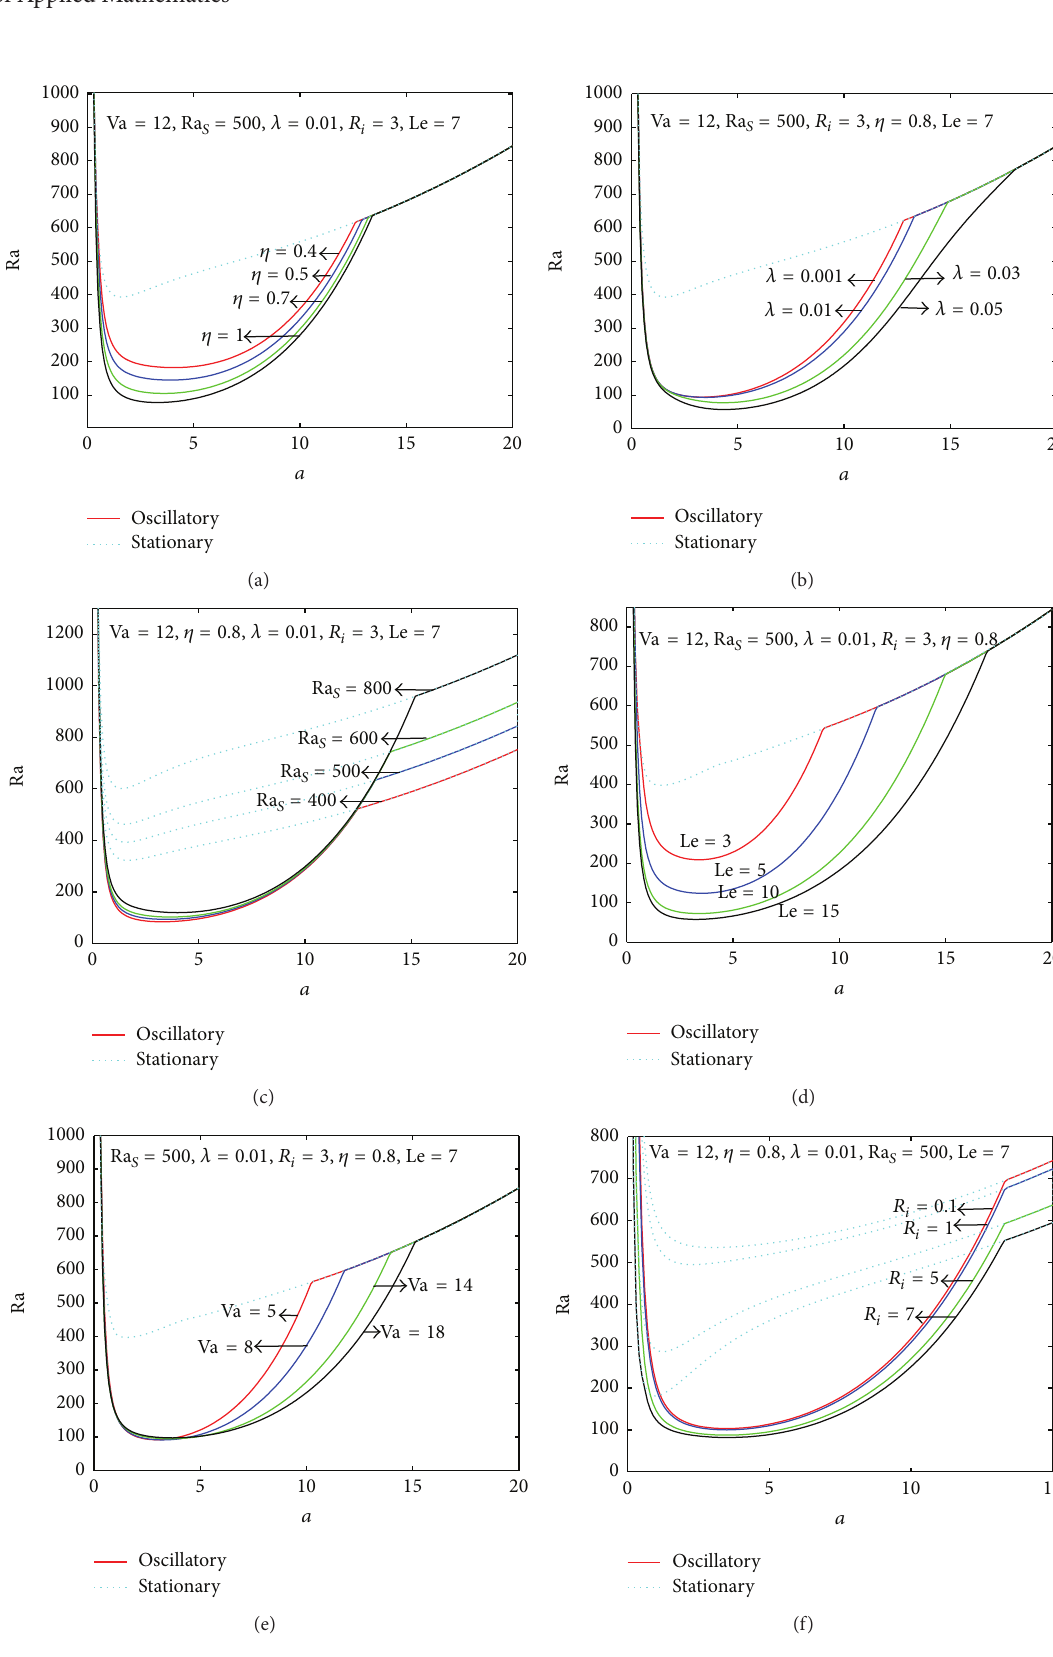
Figure 1: Variation of Ra 𝑇 with respect to wave number 𝑎 for neutral stability curves for different values of